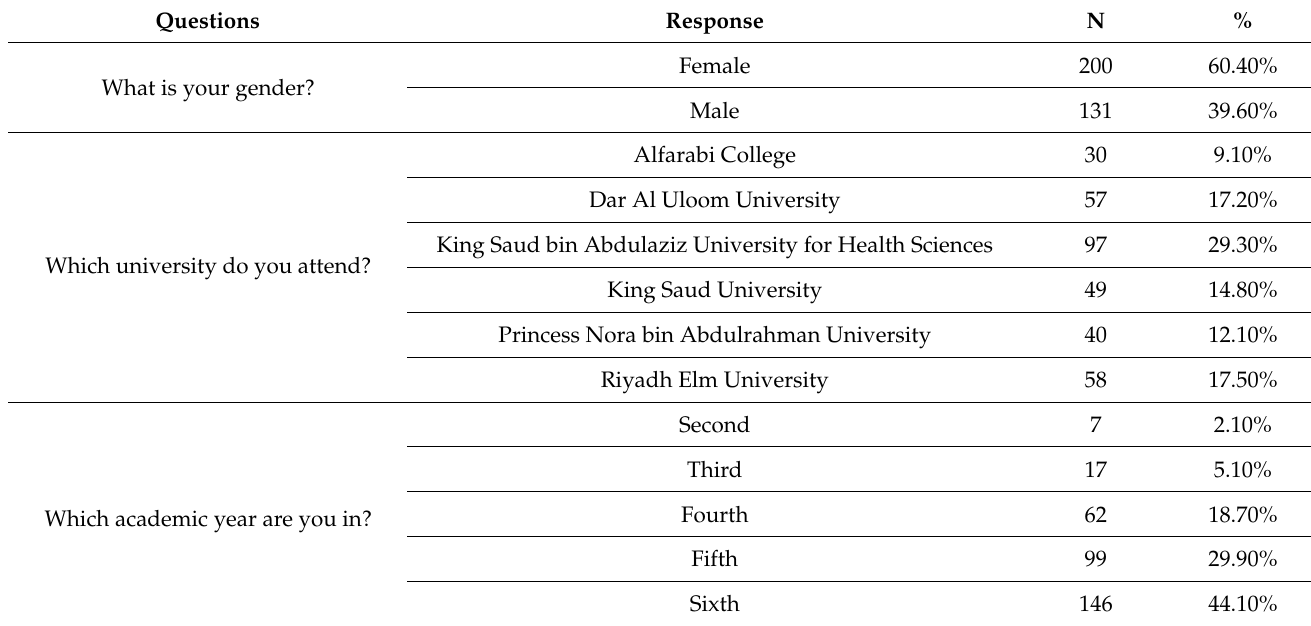
Table 1. Demographic details of the study participants.